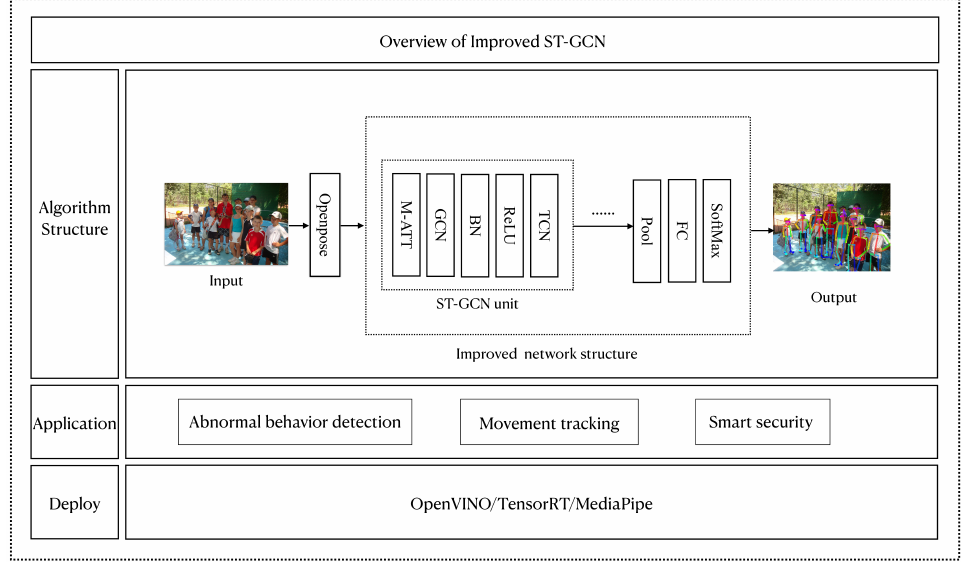
Figure 4. Overview of improved